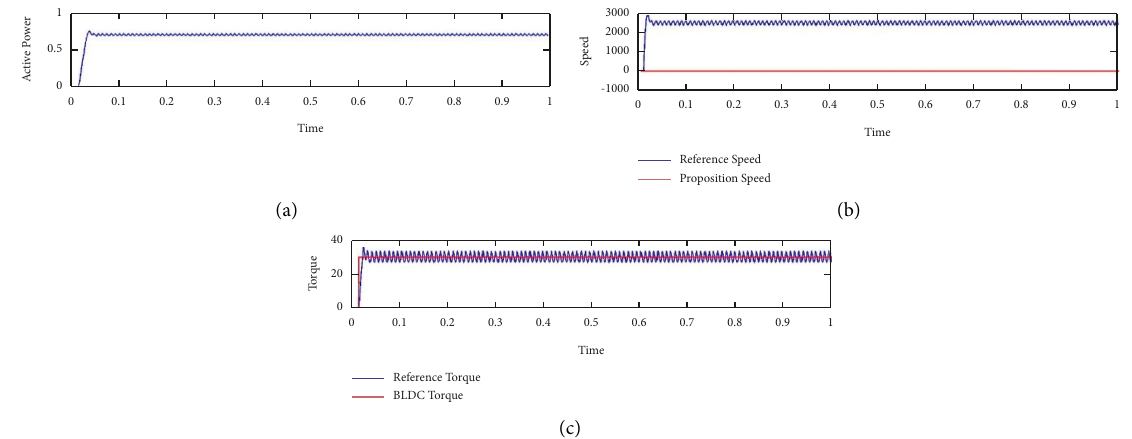
Figure 19: ANN designed. (a) Active power. (b) Reference speed and propulsion speed. (c) Reference torque and BLDCM torque of the BLDC motor.